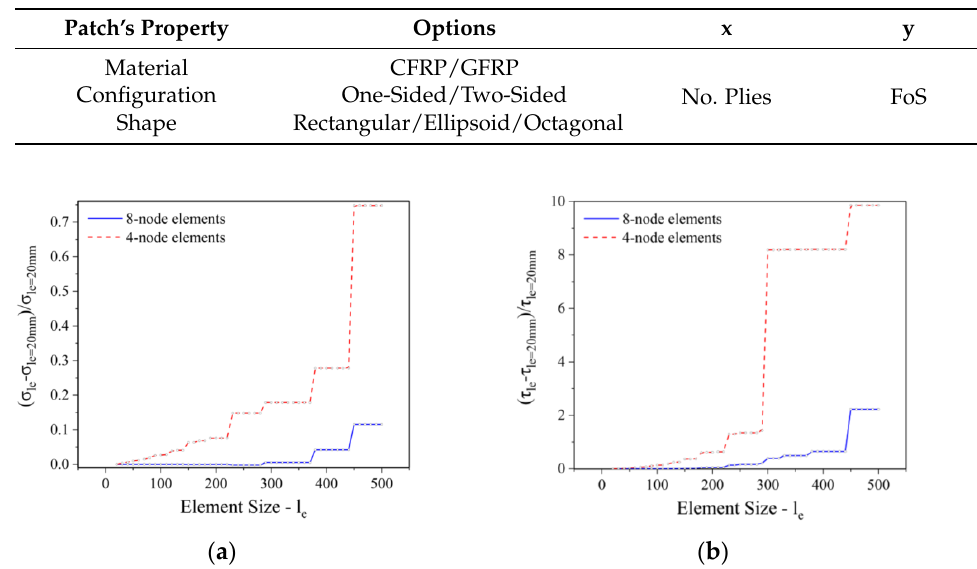
Figure 13. Mesh convergence test for the ( a ) compression and ( b ) shear buckling model.